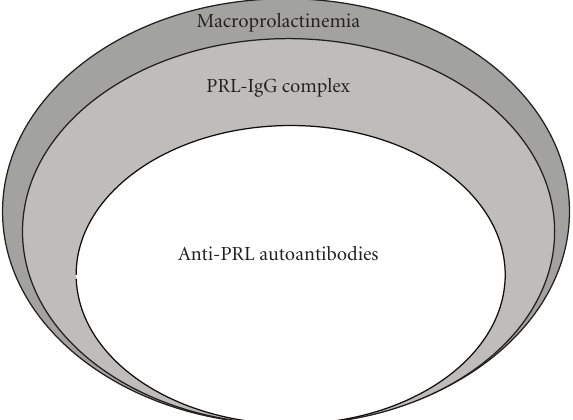
Figure 1: Macroprolactinemia, IgG-bound PRL, and anti-PRL autoantibodies. Macroprolactinemia is a heterogeneous condition with di ff erent etiologies; 87% of macroprolactin was PRL-IgG complex and 67% of macroprolactin was autoantibody-bound PRL [15]. Although anti-PRL autoantibody-bound PRL is a major form of PRL-IgG complex and PRL-IgG complex is a major form of macroprolactin, there may be PRL-IgG complex other than autoantibodies and macroprolactin other than PRL-IgG complex as shown in grey area. The diagnosis of macroprolactinemia is made based on the results of PEG-precipitation method or gel filtration chromatography, IgG-bound PRL by protein A or protein G column method, and anti-PRL autoantibody-bound PRL by 125 I- PRL binding